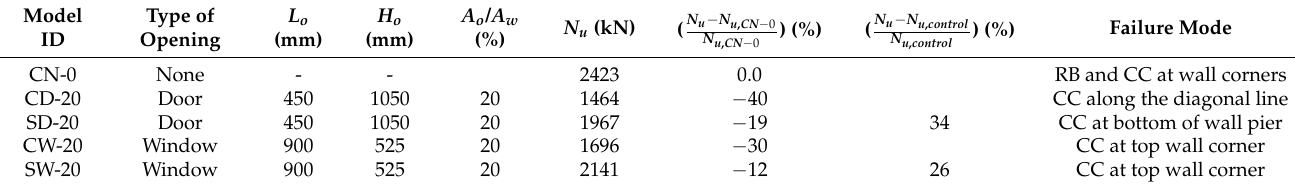
Table 4. Results of wall models with various opening types.